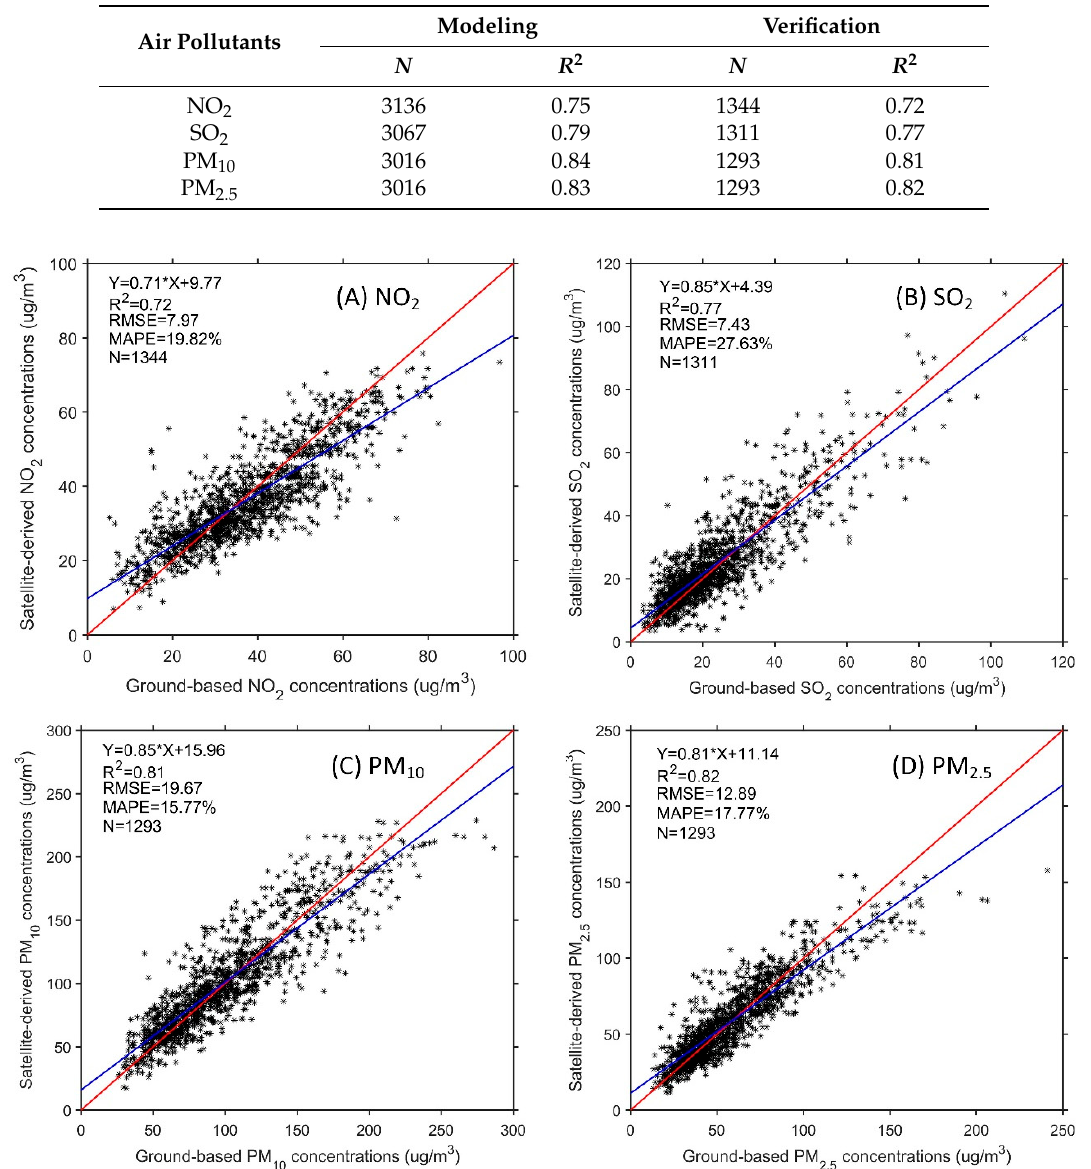
Table 3. Model fitting and verification of air pollutants estimation.